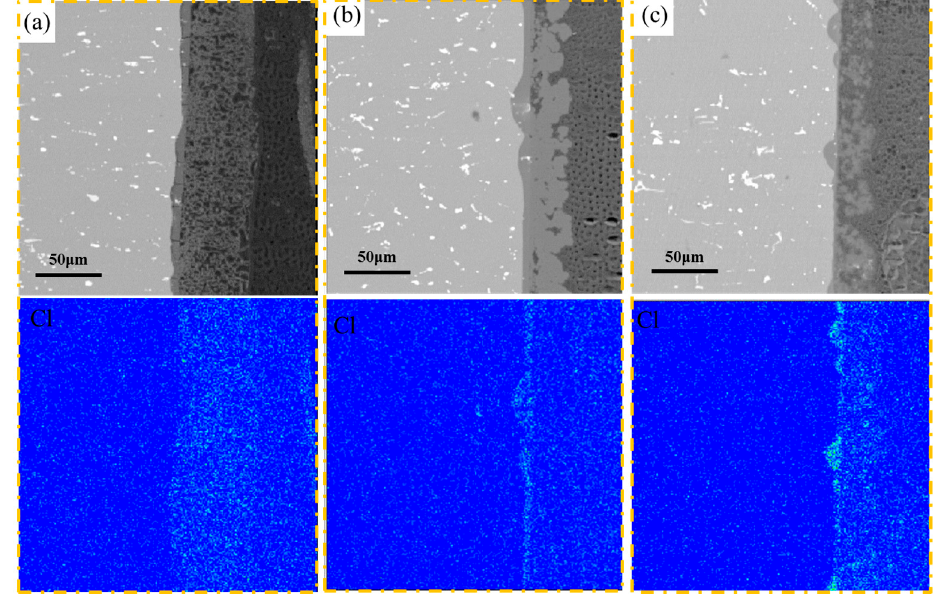
Figure 13. EPMA maps of the elemental distribution of the cross-section of 2A02 Al alloy after corrosion for 200 h at ( a ) 30; ( b ) 60; ( c ) 80 °C.